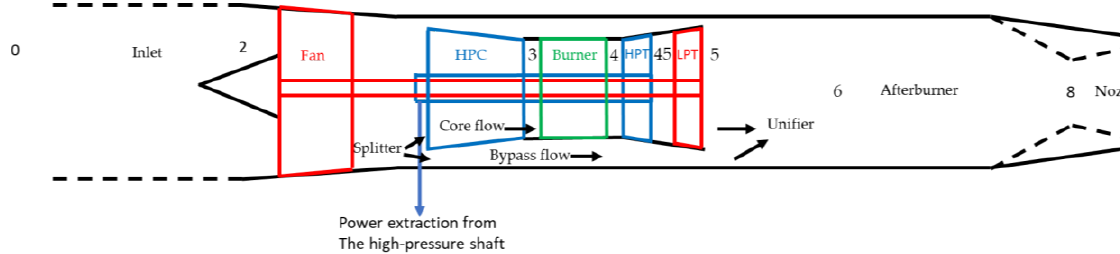
Figure 1. Overview of the modeled engine. The engine model consists of the following